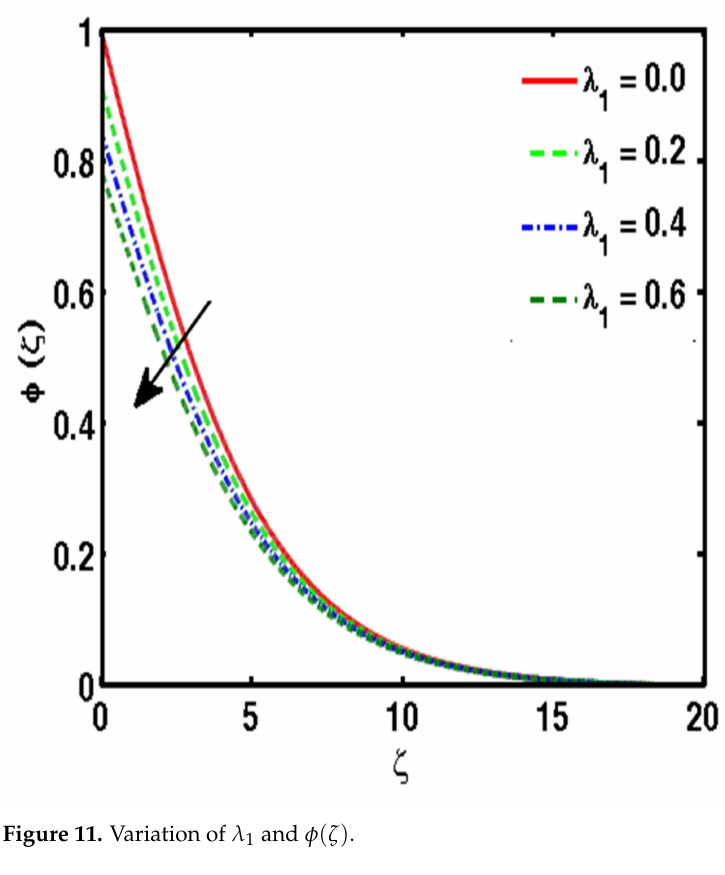
Figure 11. Variation of λ 1 and φ ( ζ ) .